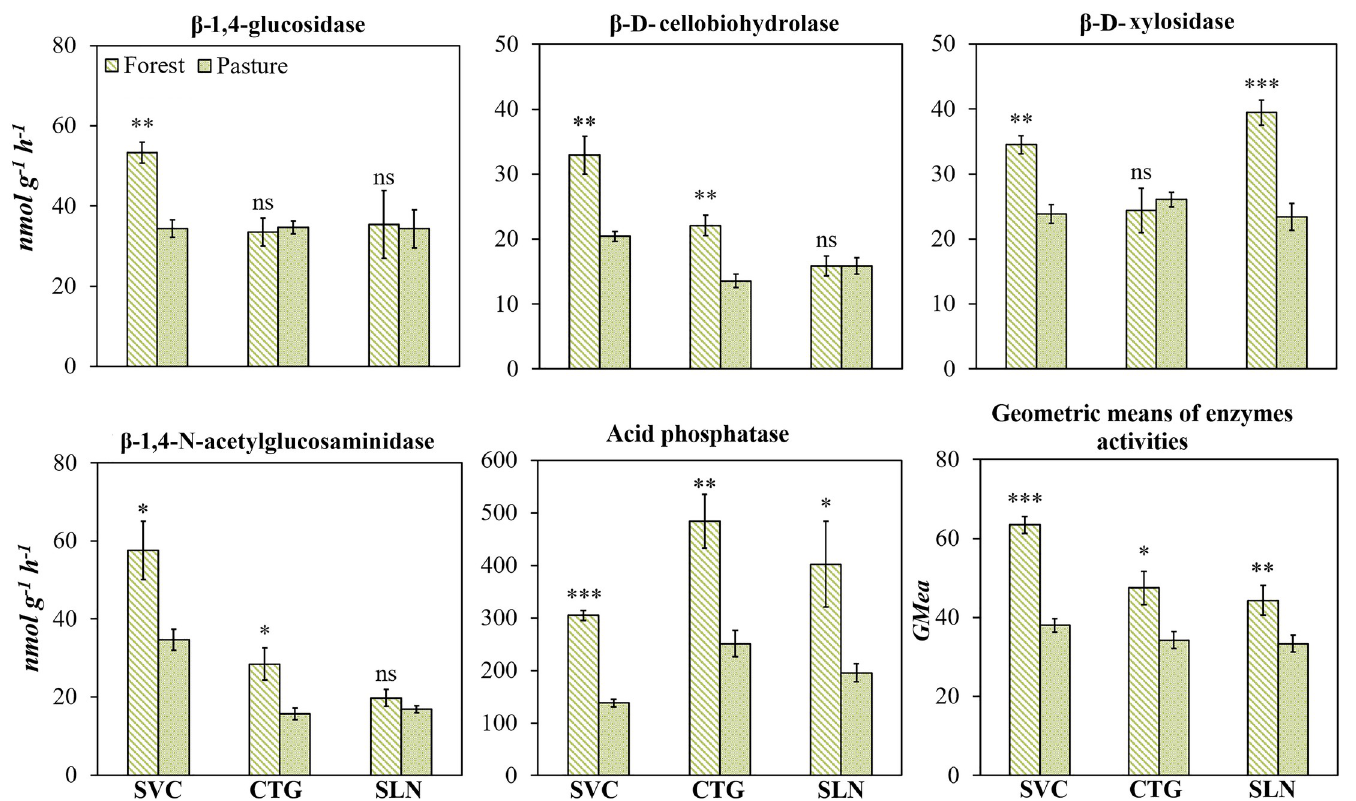
Fig 4. β -1,4-glucosidase, β -D-cellobiohydrolase, β -D-xylosidase, β -1,4-N-acetylglucosaminidase, acid phosphatase enzymes activities in the soil of forest and pastures located in hills landscape (SVC: San Vicente del Caguan, CTG: Cartagena del Chaira, SLN: Solano) of Colombian Amazon region; as well as the index of geometric mean enzyme activity. Error bars denote standard error. The asterisk indicates that the means values of soil and litter differ significantly between themselves to the level p < 0.05.